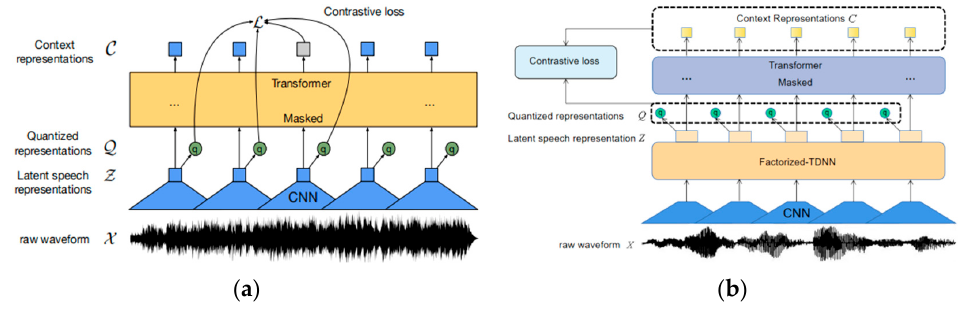
Figure 3. ( a ) wav2vec2.0; ( b ) wav2vec-F.